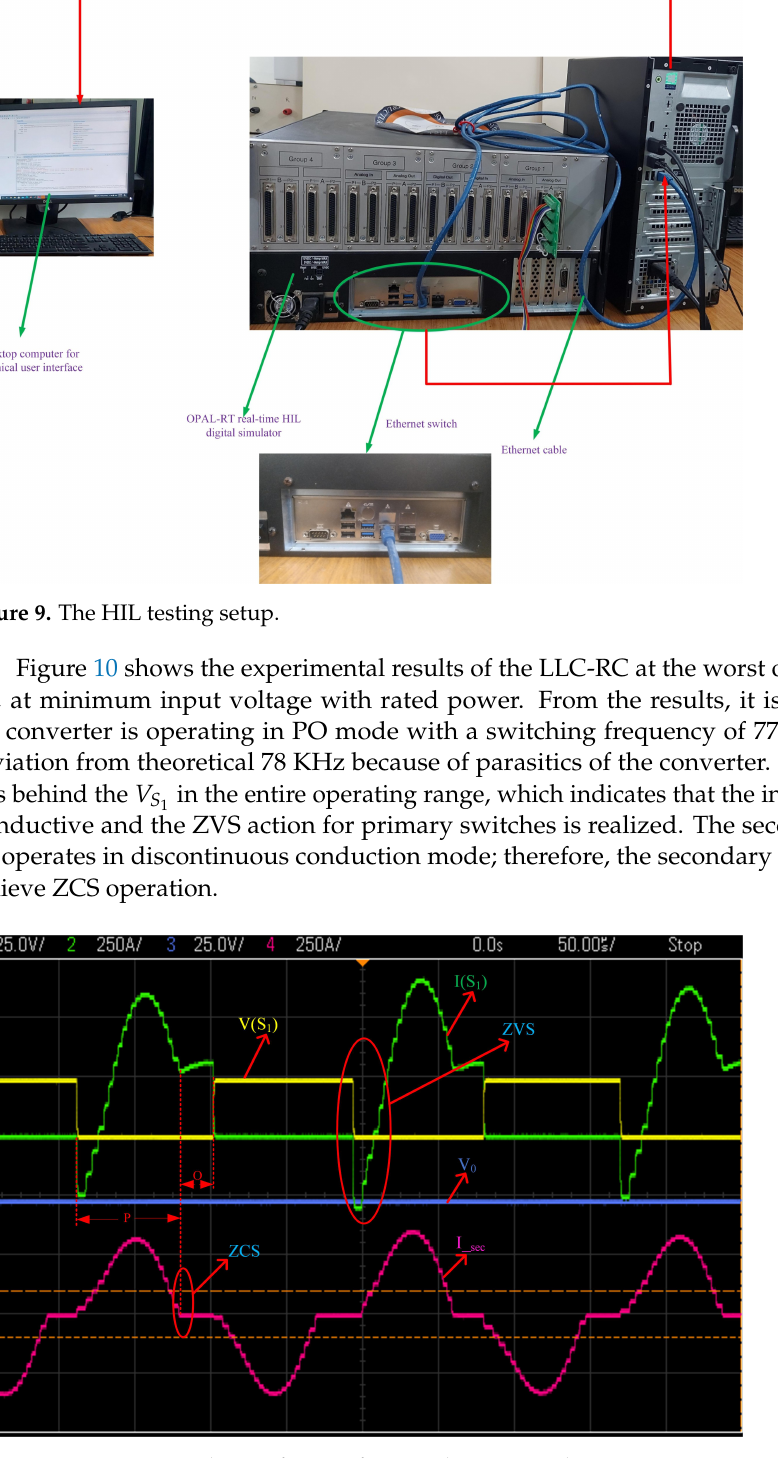
and I S , V 0 and I sec at minimum input voltage with 1 1